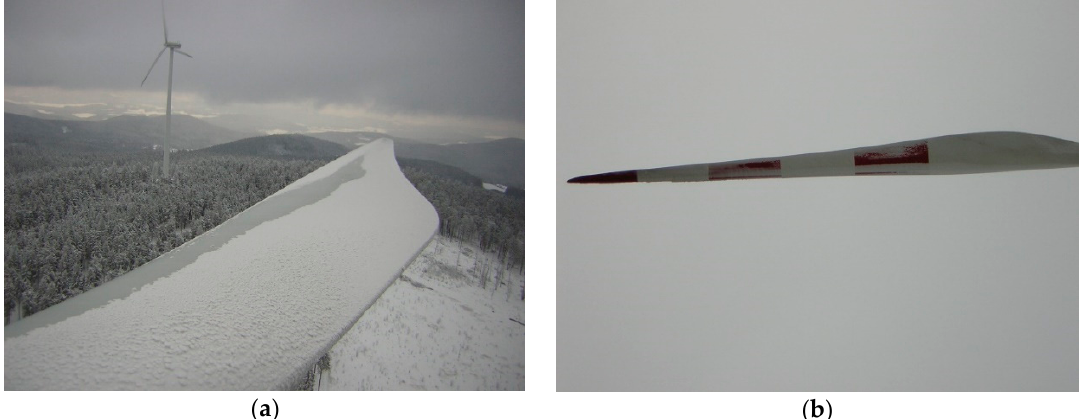
Figure 1. Typical icing conditions on the rotor blade of a glass fibre-reinforced plastic (GFRP) wind turbine,( a ) top view and ( b ) rear view with ice accumulation